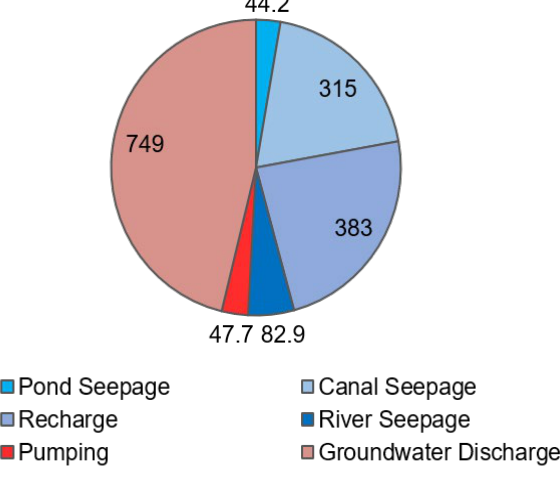
Figure 7. Baseline groundwater balance components for the simulation period. Values are in millions of m 3 . Red colors indicate system outflows (pumping, groundwater discharge); blue colors indicate system inflows (recharge pond seepage, recharge, canal seepage, seepage from the South Platte River).